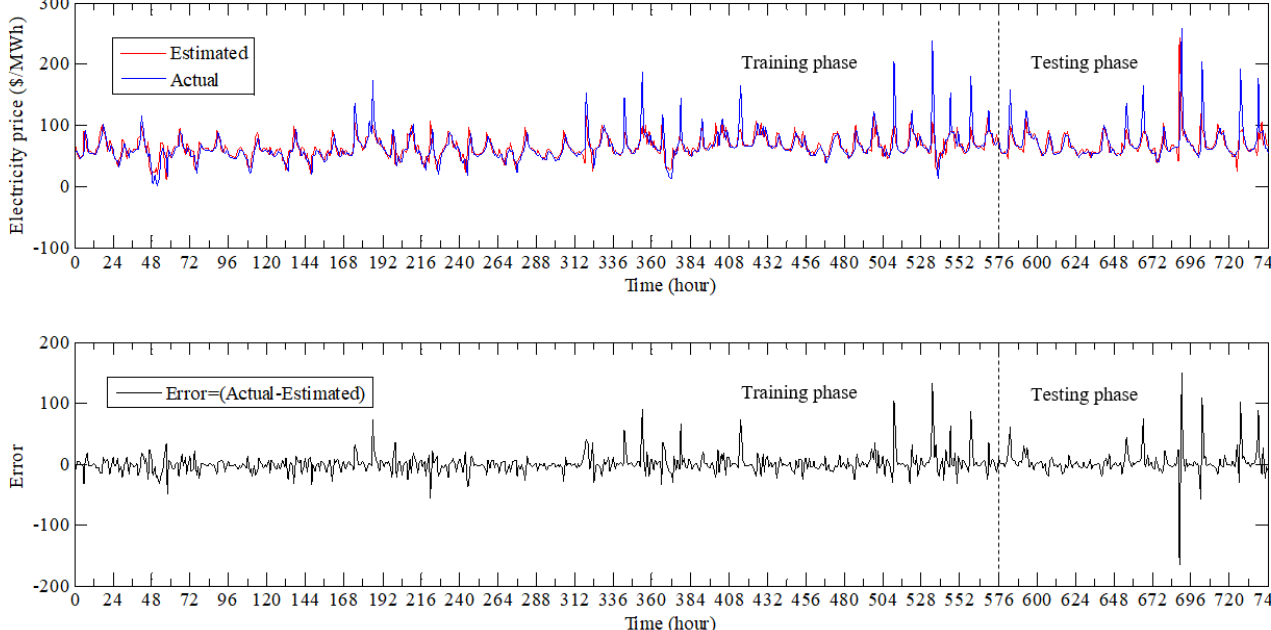
Figure 6. The evaluation of the performance throughout training at the designing and testing phases of ANFIS-BSA and its corresponding error of EPF in May 2018 for QLD.